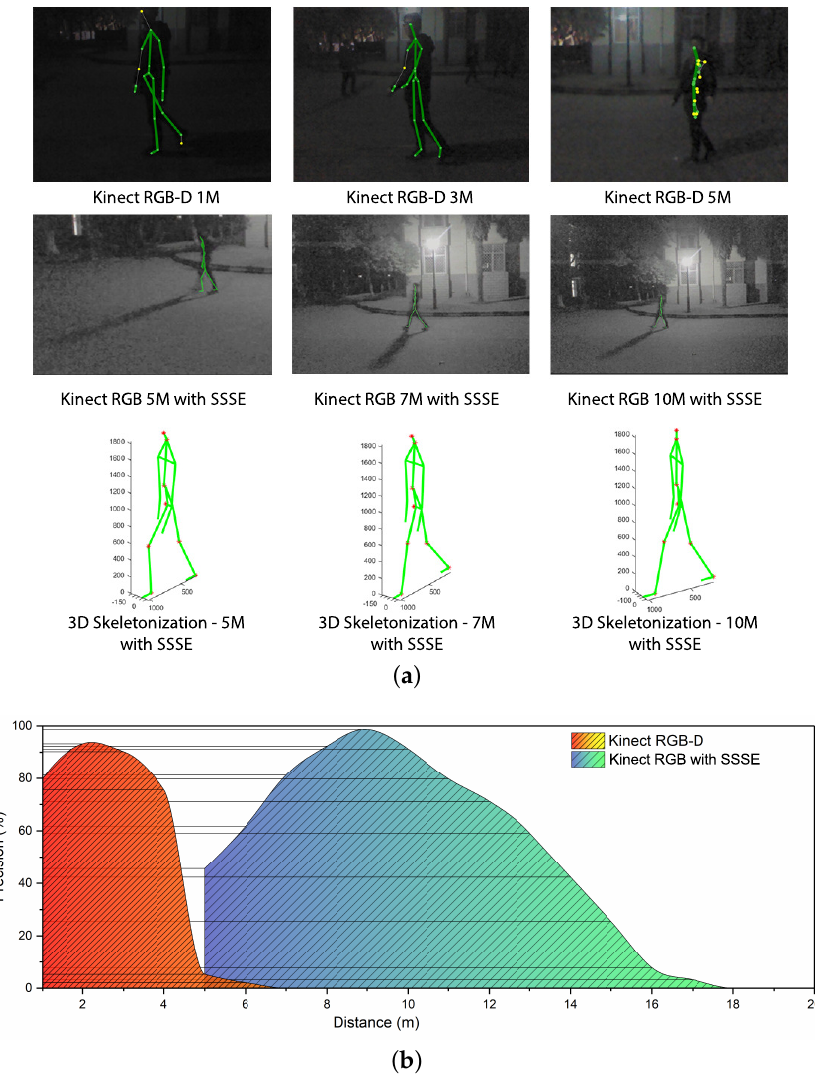
Figure 6. Experimental results. ( a ) A comparison of tracking results; ( b ) Effective ranges of RGB-D-based results and SSSE-based